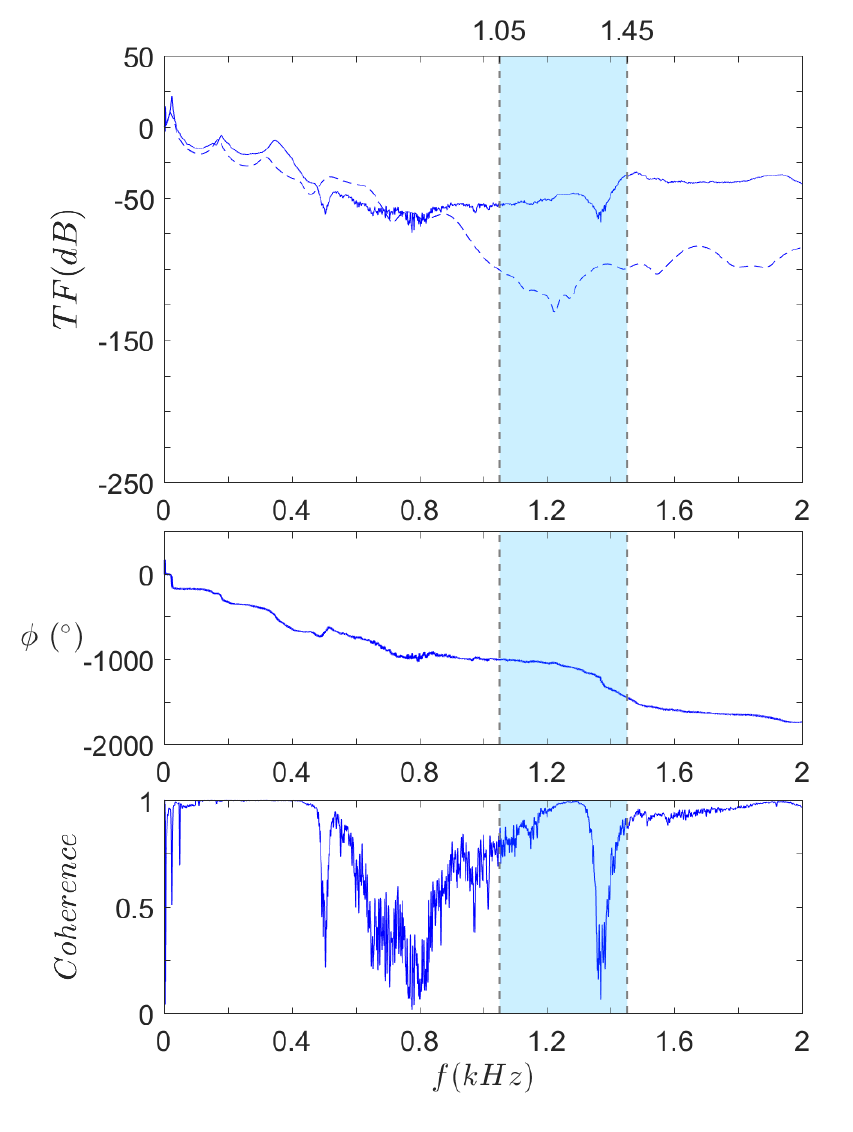
Figure 16. Transfer function ( top ), phase ( middle ), and coherence ( bottom ) of S 0 . Experimental and computed results. Omnidirectional bandgaps under 2 kHz, as found in the disper- sion